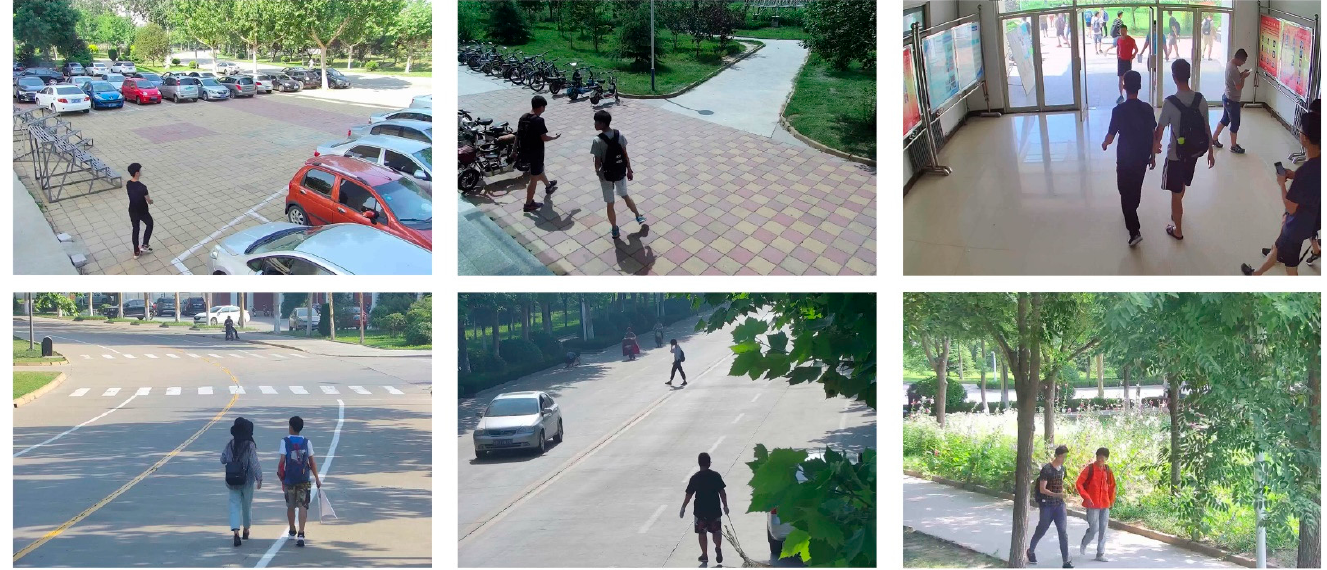
Figure 3. Examples of the surveillance video database.